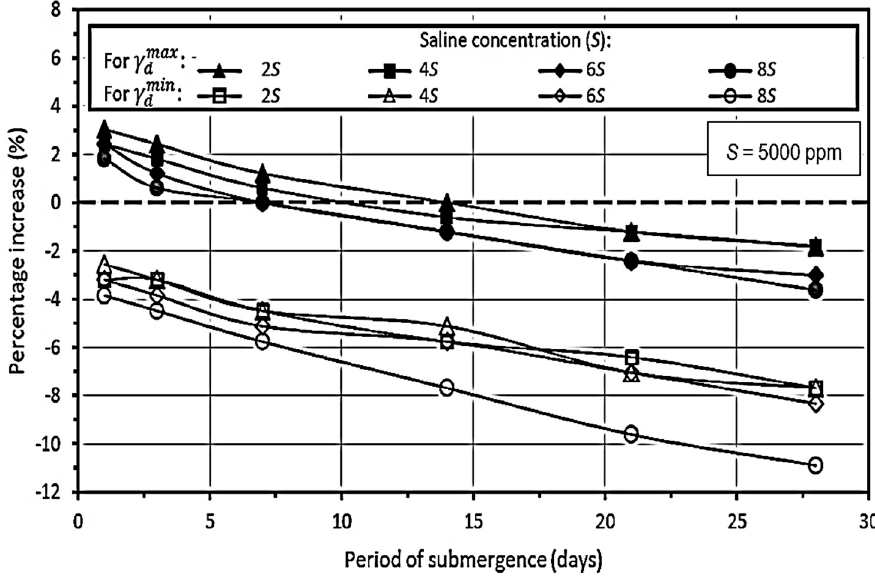
Figure 8. Variation of percentage increase in dry densities with period of submergence. Figure 9 portrays the variation of normalized dry densities with saline